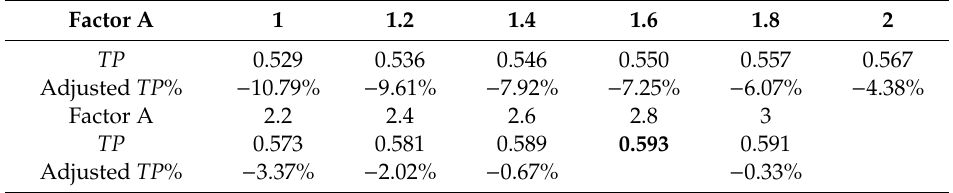
Table 2. The values for the TP and the adjusted TP % resulting from a 0.2 level change in factor A. Factor A